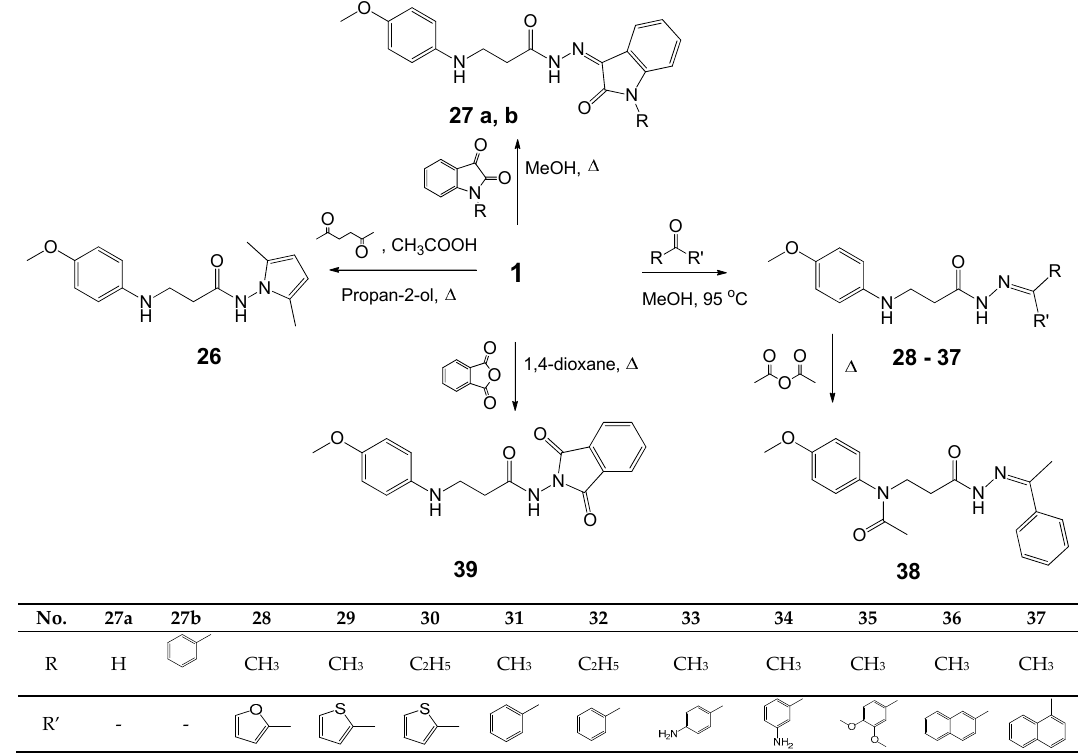
Scheme 3. Synthesis of compounds 26 – 39